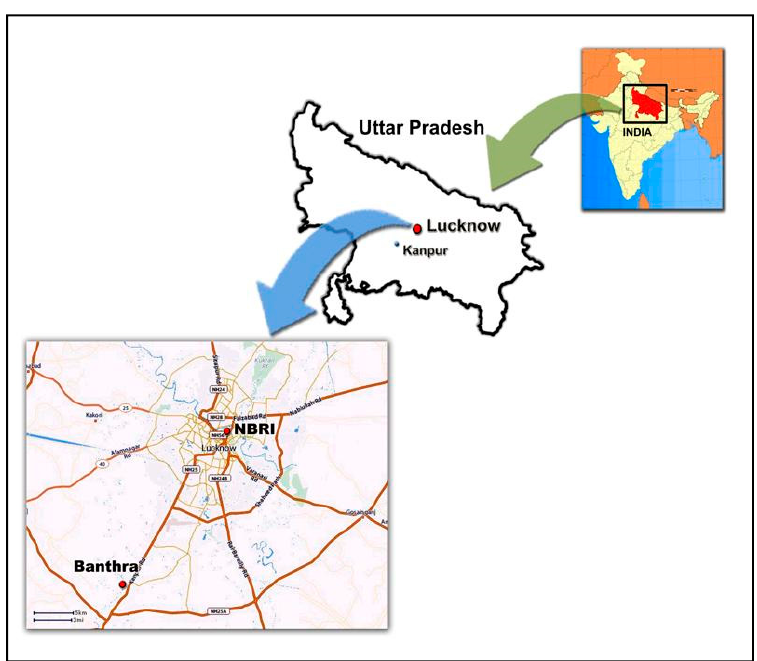
Figure 1. The location of experimental sites in Lucknow, state of Uttar Pradesh, India.